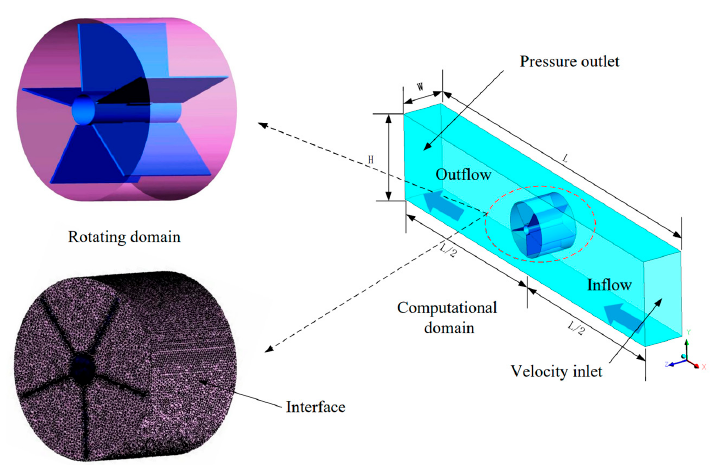
Figure 2. Computational domain and boundary conditions.